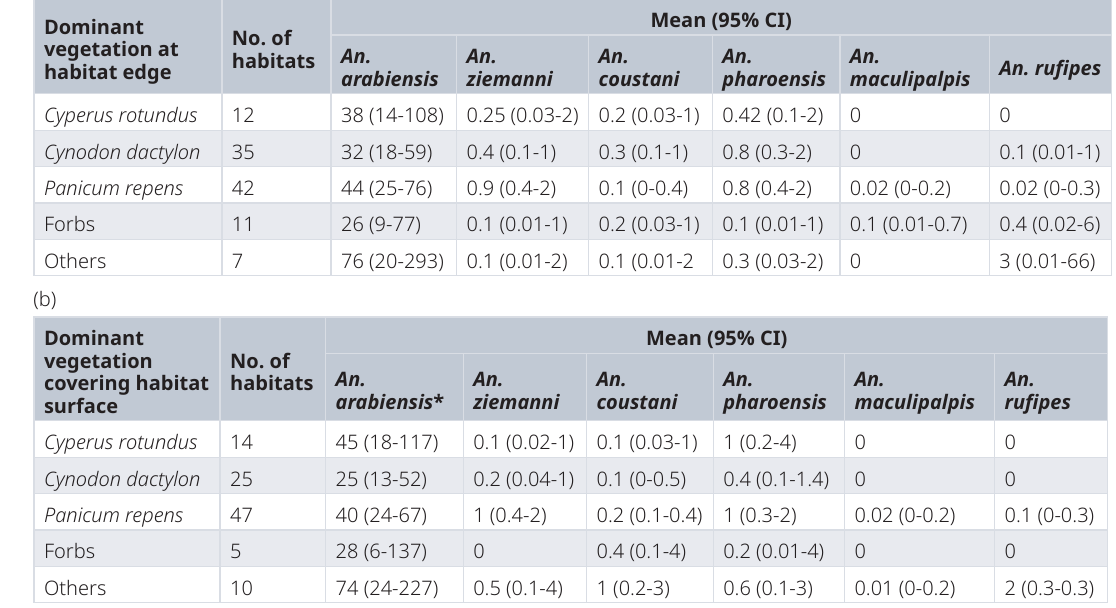
Table 4. Dominant vegetations (a) at the edges and (b) at the surfaces and mean number of Anopheles mosquitoes. (a)